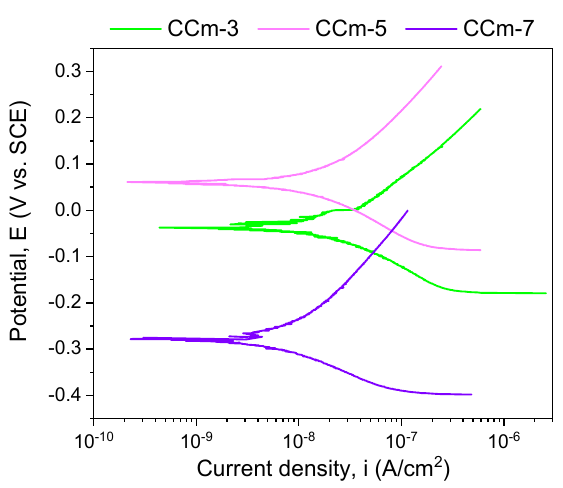
Figure 9. Tafel plots of cast Co-Cr alloy in all testing media.